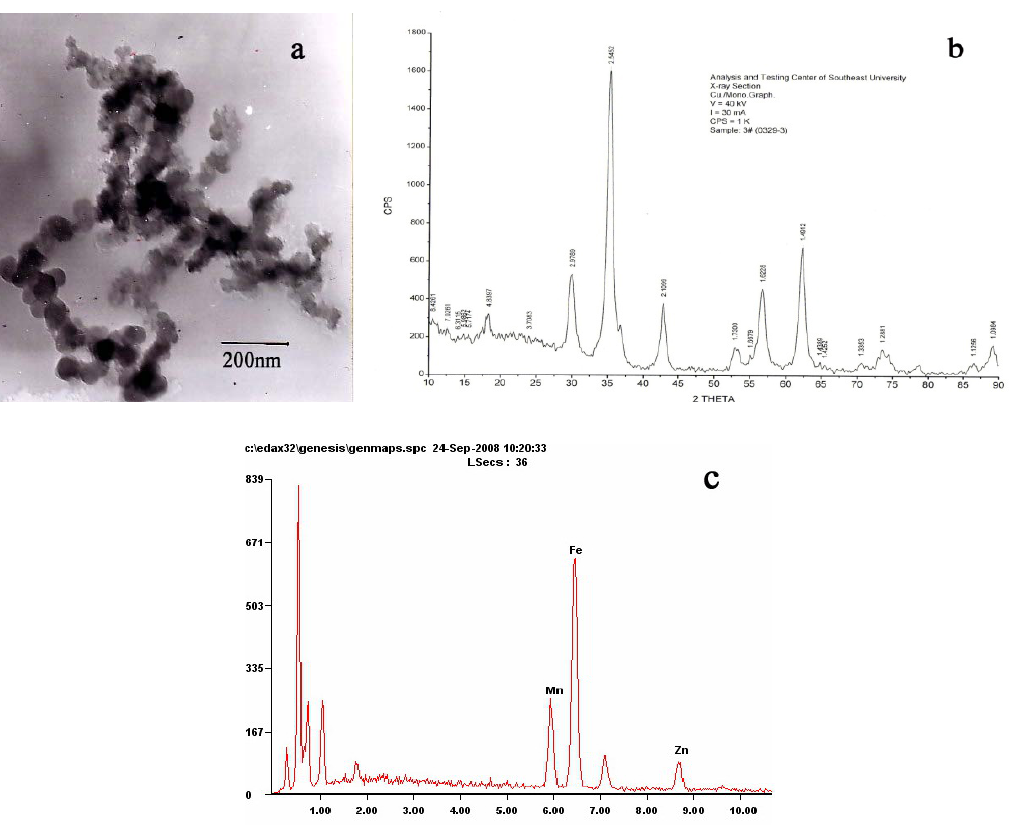
Zn Fe O (a) TEM image of the nanosized 0.5 0.5 2 4 .